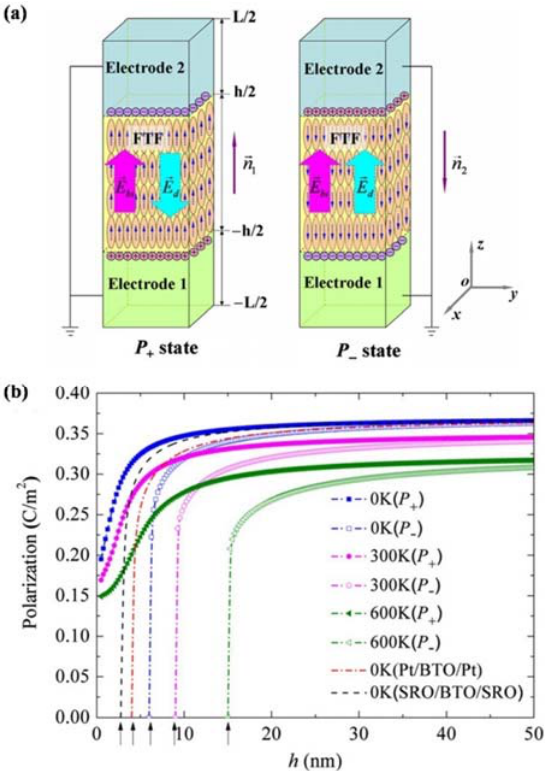
Figure 9. ( a ) Schematic configuration of an asymmetric-FTJ (A-FTJ) or asymmetric ferroelectric capacitor (A-FC) with n||PP n||PP  state (left), and  state (right). 1 2   Since the asymmetric electrodes break the inversion symmetry of FC, the total free energy is certainly determined by the directions of polarization. Thus the spontaneous polarization P can be expressed as , and , in which n||P n||P n and n are the unit vectors 1 2 1 2   pointing to the positive and negative z direction; ( b ) polarizations as functions of the ferroelectric thin film (FTF) thickness h of BTO A-FC, with arrows depicting the critical thickness